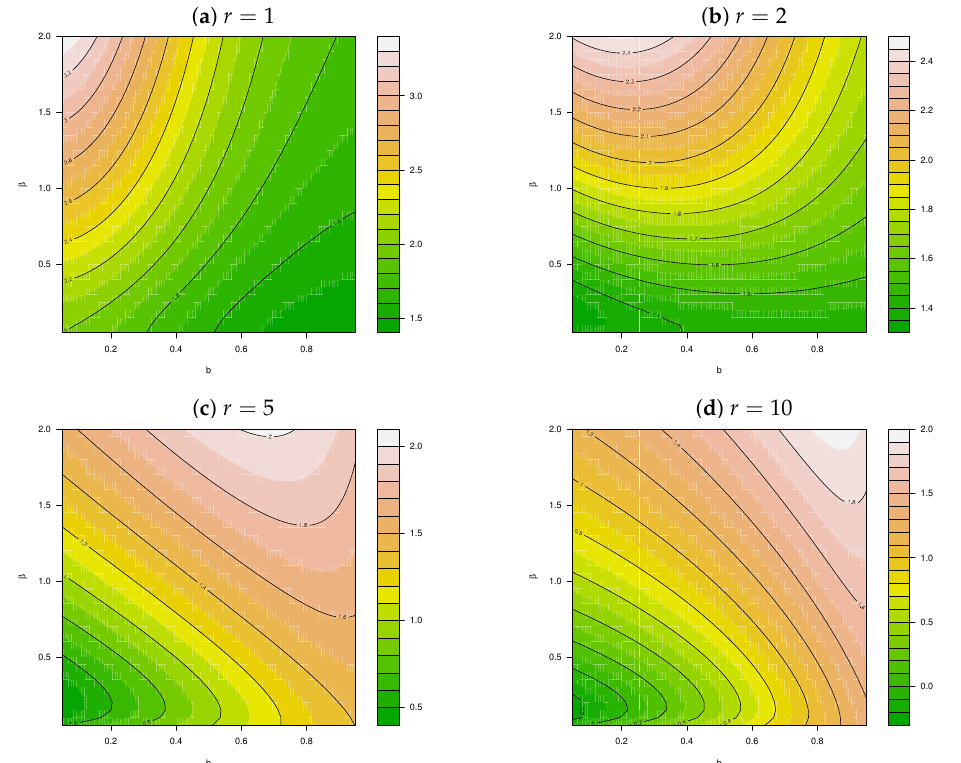
Figure 3. Skewness for Y ∼ ncLII ( β , b , r ) for different values of ( β , b ) and r = 1,2,5,10.